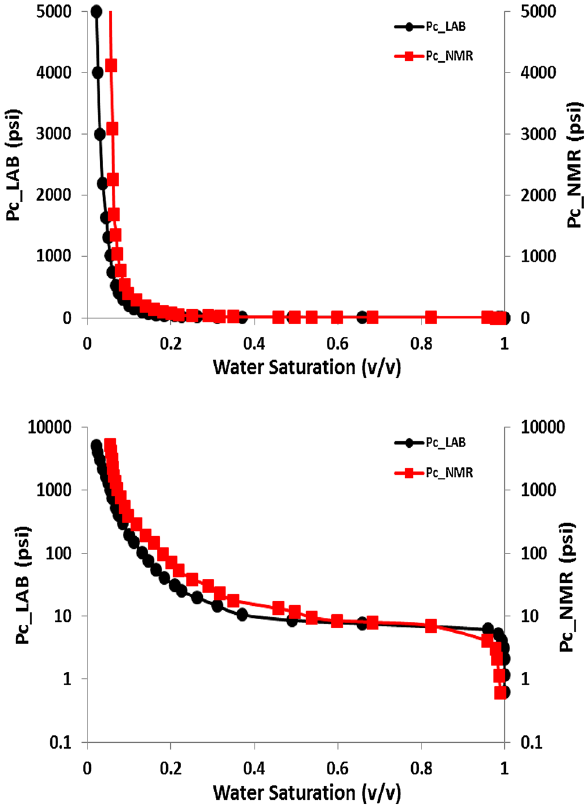
Fig. 19 Measured capillary pressure (black) and NMR capillary pres- sure (red) for the channel storey margin unit indicating a closer match between the entry pressures with much discrepancy with